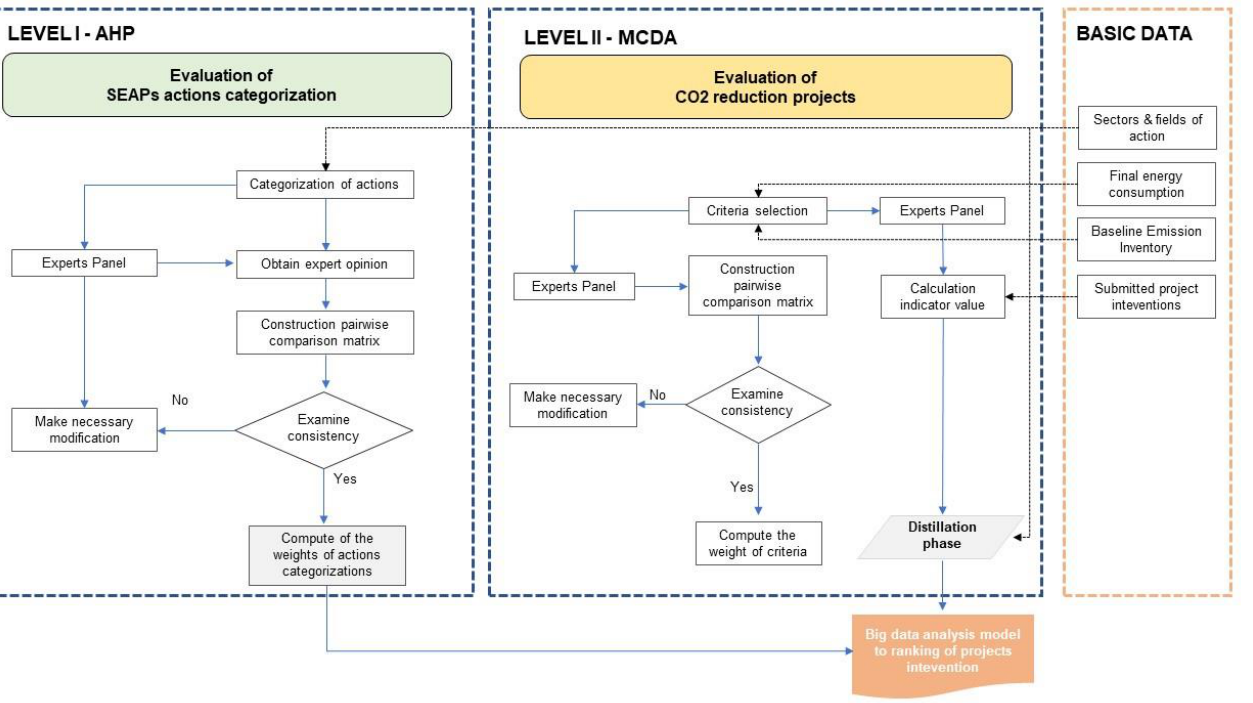
Figure 1. The logical framework of the proposed integrated methodology.